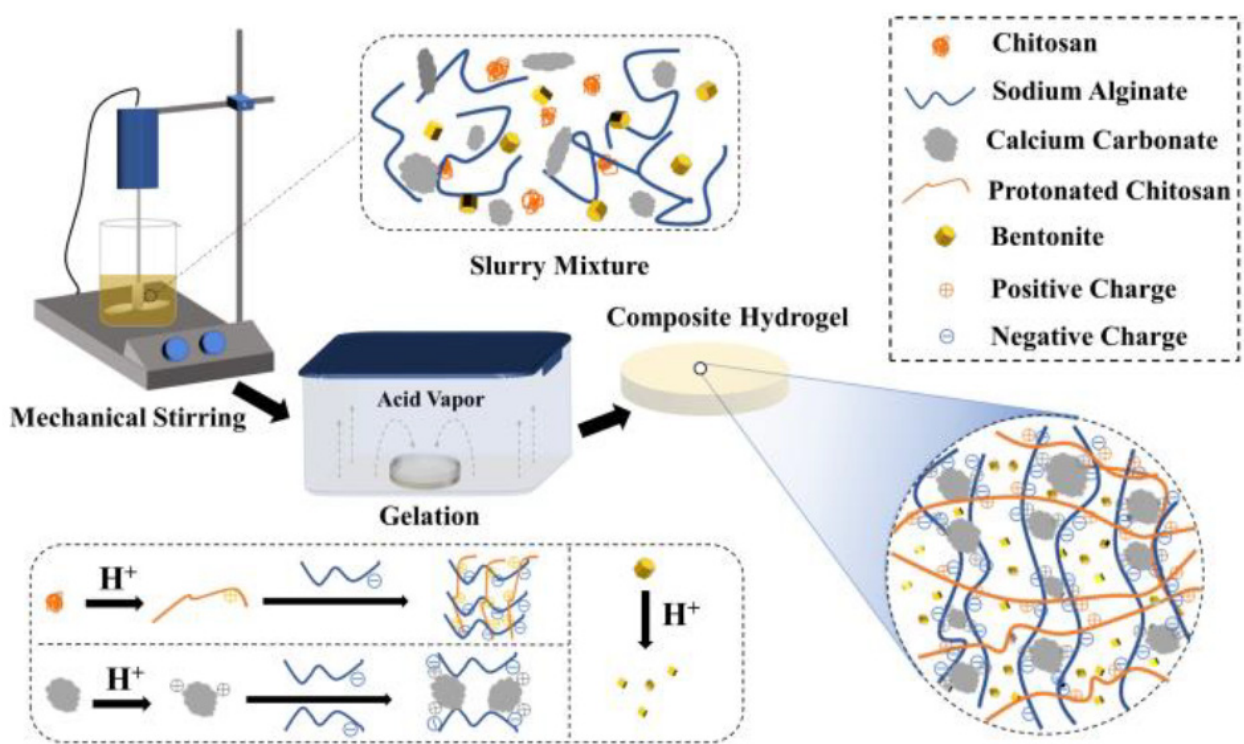
Figure 1. Schematic diagram of preparation process of CTS/CA/BT composite hydrogel.